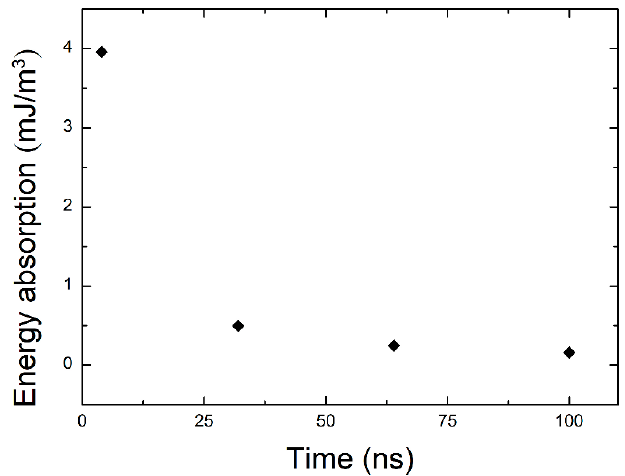
Figure 4. Total energy absorption of nanoparticles as a function of the pulse width.